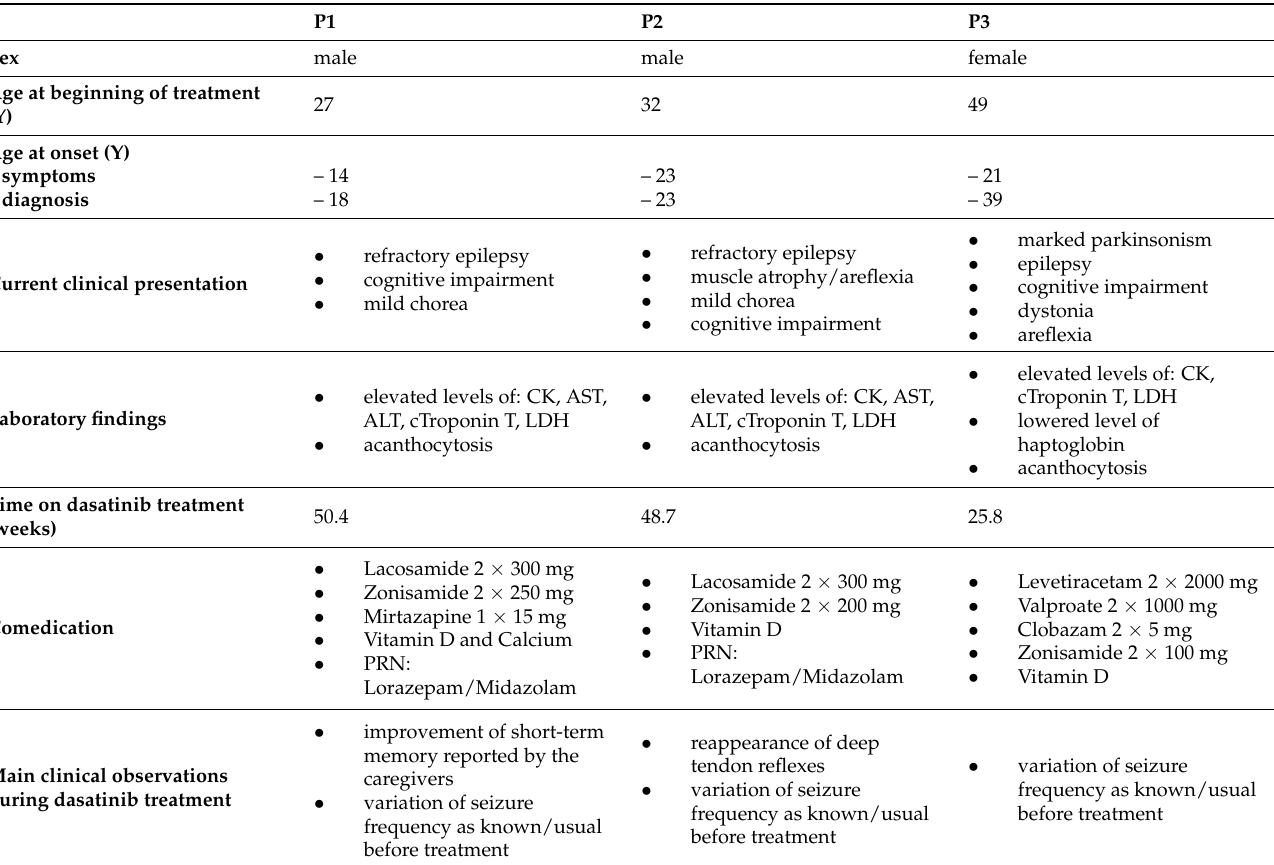
Table 1. Demographic characteristics, main clinical observations, and adverse reactions/events in chorea-acanthocytosis patients treated with